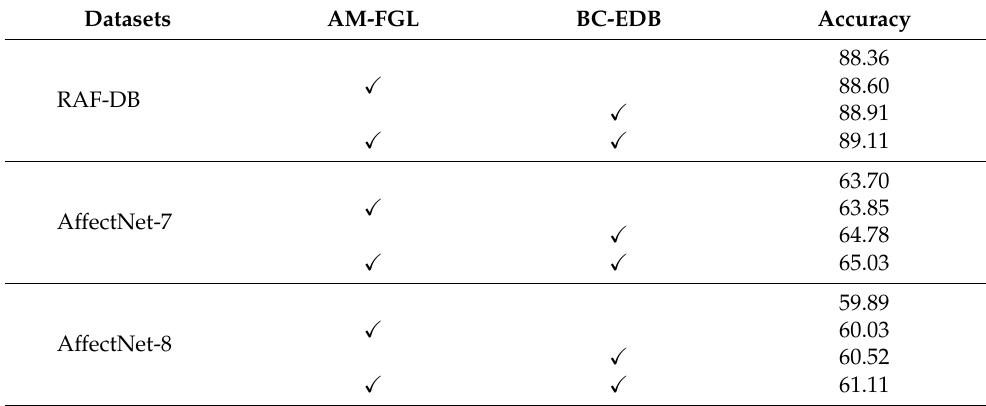
Table 9. A checkmark, (cid:88) , means that we have added this module, and no (cid:88) means that it does not contain this module. Experiments can prove that the two added modules are